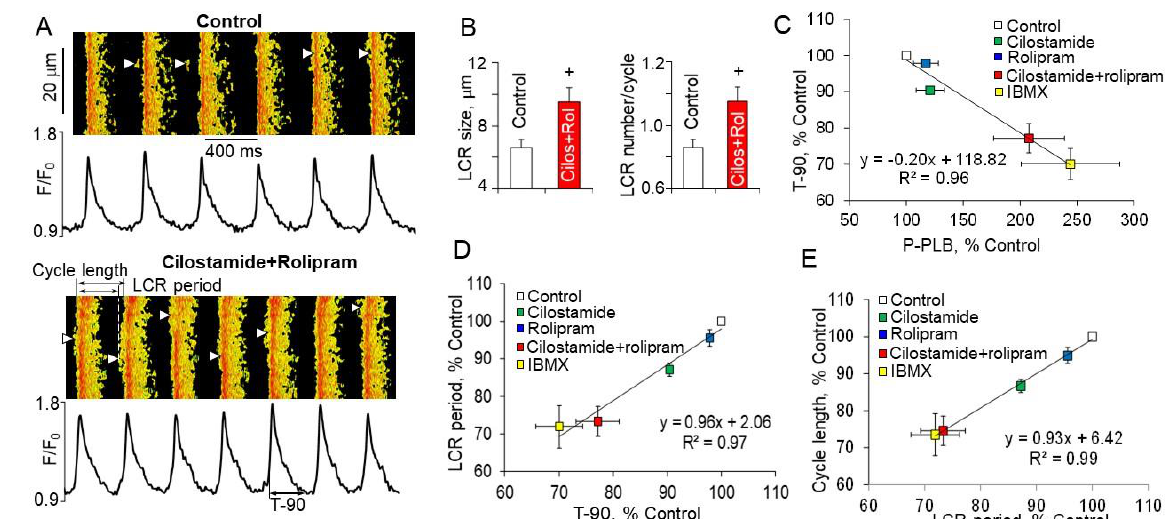
Figure 9. Dual PDE3 + PDE4 activation regulates basal LCR period and characteristics in intact rabbit SANC. ( A ) Confocal line-scan images of representative intact SANC depicting AP-induced Ca 2+ transients and LCRs (arrowheads) during spontaneous beating: (top) in the basal state and (bottom) during concurrent PDE3 + PDE4 inhibition by 0.3 µmol/L cilostamide and 2 µmol/L rolipram. Normalized subsarcolemmal fluorescence averaged over image width is shown in black beneath the image. Insets in the bottom panel show definitions of the LCR period, spontaneous cycle length and time to 90% decay of AP-induced Ca 2+ transient (T-90). ( B ) Dual PDE3 + PDE4 inhibition markedly increases (left) the LCR size and (right) LCR number per each spontaneous cycle (n = 7 SANC, 4 rabbits), t -test, + p < 0.01. ( C ) an increase in PLB phosphorylation produced by inhibition of PDE3 or PDE4 alone or dual PDE3 + PDE4 inhibition is highly correlated with reductions in SR Ca 2+ refilling times (T-90, n = 4-6 SANC, 3 rabbits) and proportional shortenings of LCR periods ( D ), which predicted ( E ) decrease in spontaneous SANC cycle lengths. ( A – E from [11]).